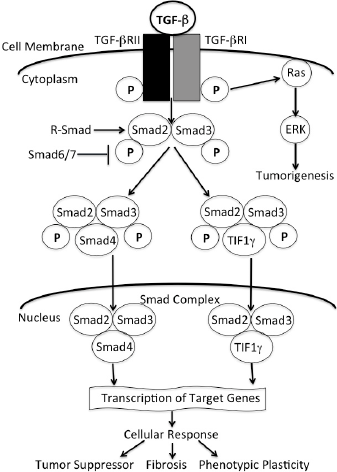
Figure 1. The TGF ‐β /Smad4 signaling pathway. The Ligand TGF ‐β binds a complex of transmembrane receptor serine/threonine kinases (Types I and II) in the cell surface and induces transphosphorylation of the receptors. The consequently activated receptors phosphorylate selected Smads at C ‐ terminal serines, and these receptor ‐ activated Smads (R ‐ Smads) then form a complex with a common Smad4. Activated Smad complexes translocate into the nucleus, where they regulate transcription of target genes, through physical interaction and functional cooperation with DNA-binding transcription factors.